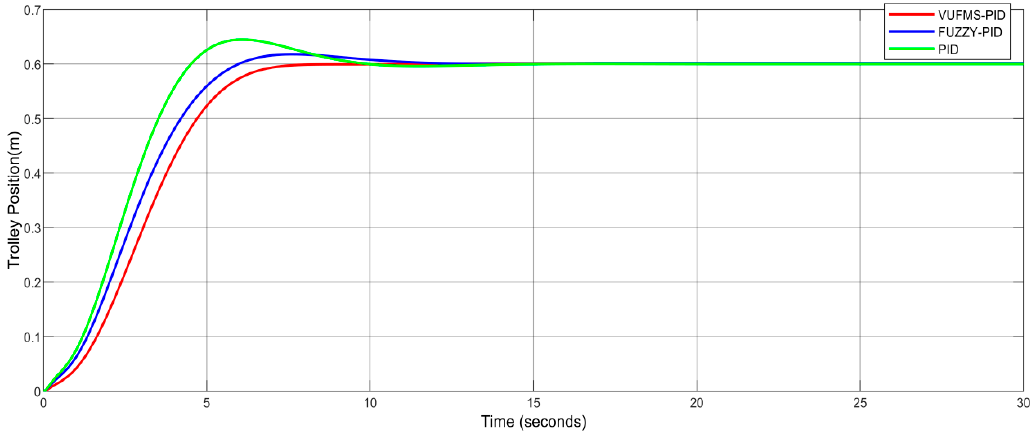
Figure 8. Trolley’s position using VUFMS-PID, FUZZY-PID and PID controller under working condition 1.